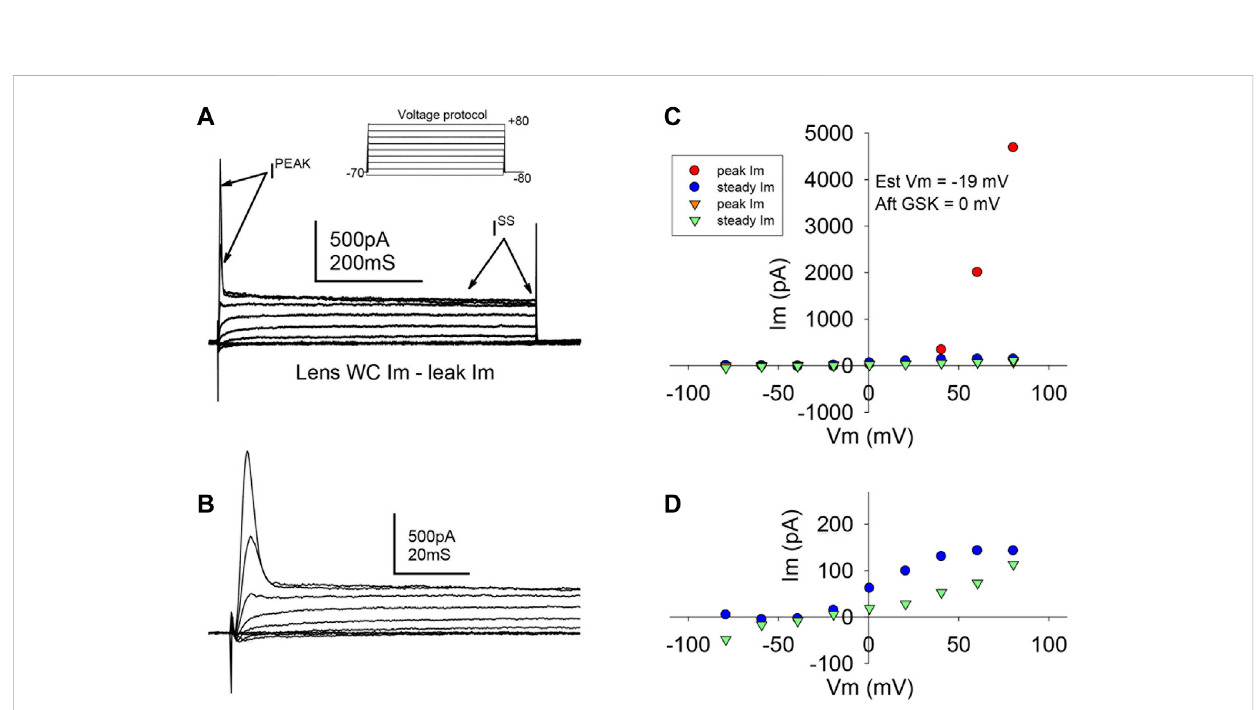
TRPV4 agonist GSK1016790A abolished a transient outward current. (A,B) Typical ionic current responses from single LEC in control conditions (A), elicited by a voltage protocol (inset) designed to explore K + outward currents (See Methods, “ step or IV ” protocol, and Results for further description).